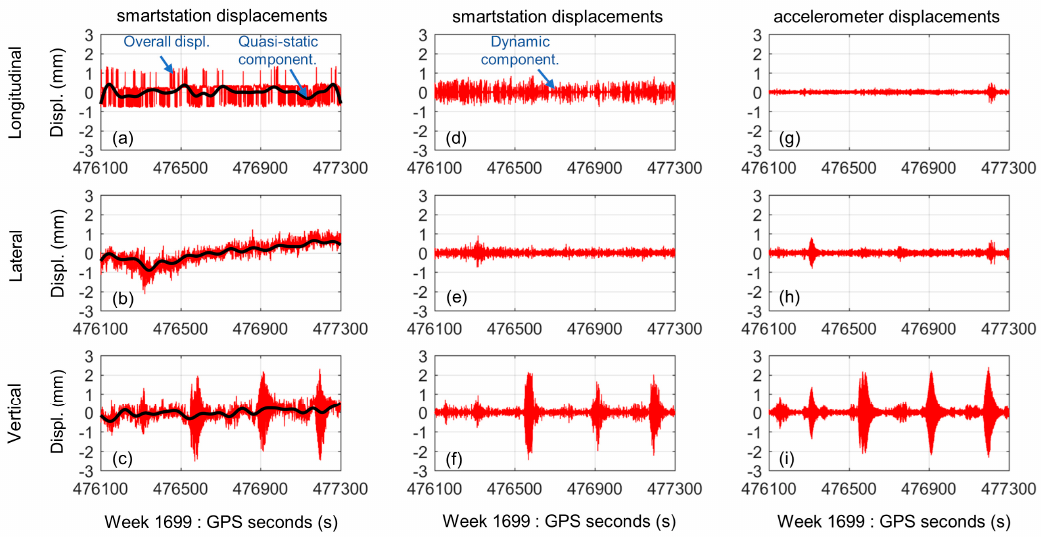
Figure 8. Time histories of displacements of the footbridge in three directions induced by gentle wind and the occasional pedestrian in experimental Case 3. The overall vibration displacements measured by the composite instrument (the red curves in the left column) were separated into two parts, i.e., the quasi-static displacements (the black curves in the left column) ( a – c ). Dynamic displacements (central column) ( d – f ). The dynamic displacements (right column) were also computed from the accelerometer data by double integration ( g – i